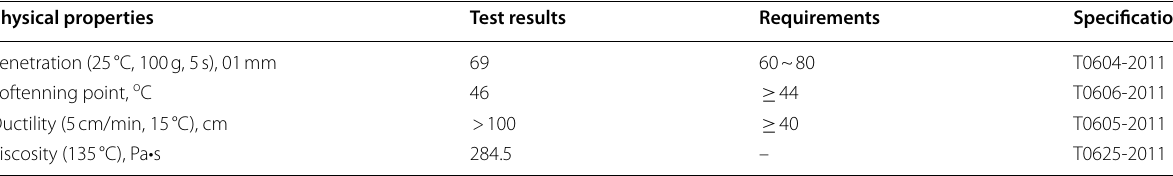
Table 1 Physical properties of the used grade asphalt binder Physical properties